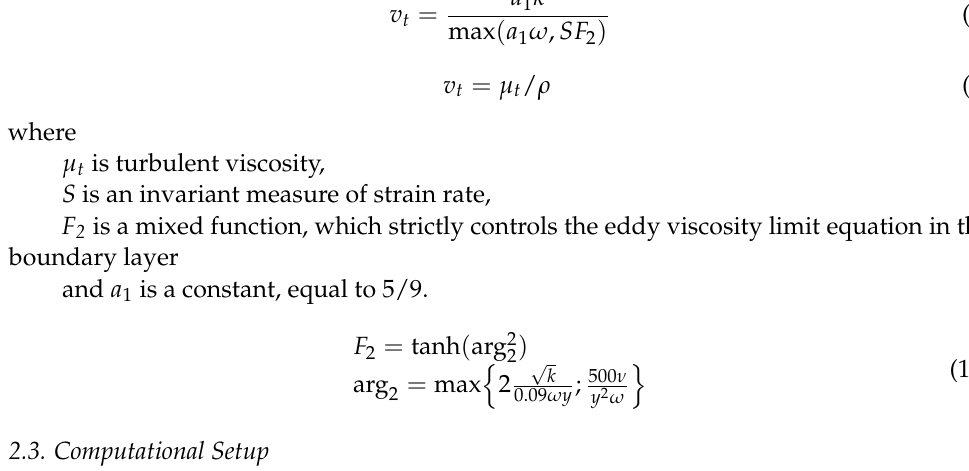
Figure 4. The y + distribution of grids near the wall of impeller and guide vane. The grids of the flow domain were generated by the commercial software ICEM CFD. The suction chamber, impeller, guide vane, support and pressurized chamber were meshed by using hexahedral elements. The grid independence was checked by increasing the number of elements and checking that the residual of the hydraulic efficiency changed by less than 0.5% when the number of elements was increased by 10%, which was shown in Figure 5. In addition, 40 layers of grids were set at the tip clearance to capture the flow field structure at the tip clearance. The growth rate of the boundary layer grids was con ‐ trolled by 1.2. At the same time, this study adopted the processing method of completely consistent correspondence between interface grids nodes to eliminate the data transmis ‐ sion error caused by the inconsistency of interface grids between the rotor domain and stator domain. The final grids were summarized in Table 4 and illustrated in Figure 6. The final grids number is much larger than that required by the grid independence.